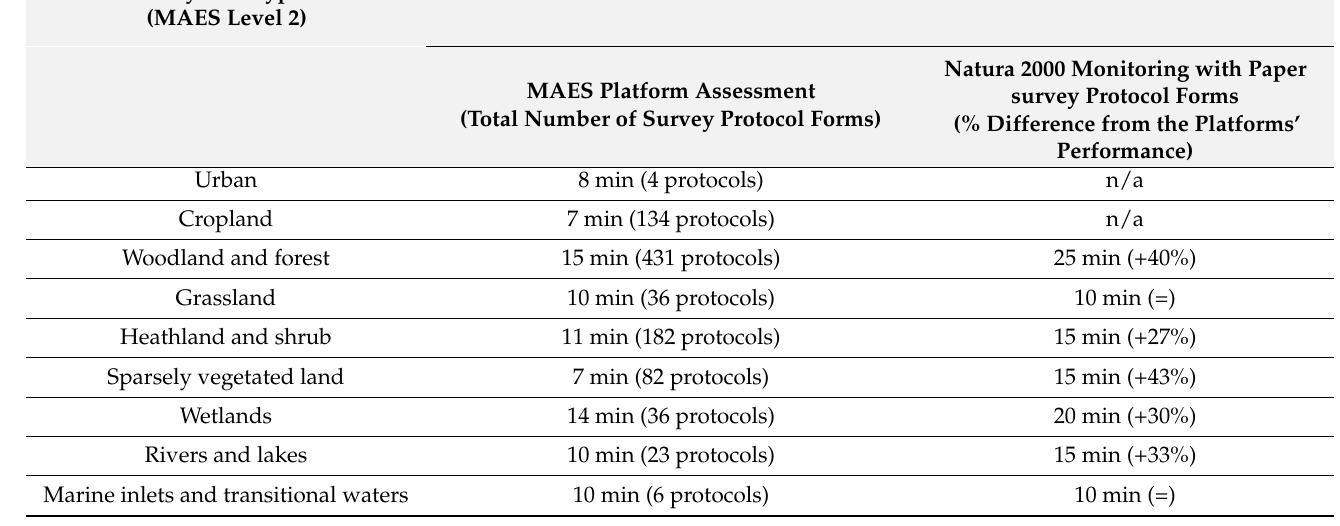
Table 3. Time spent to complete a full assessment at each ecosystem type (plot) using the MAES_GR platform in comparison with the relevant action during the habitat monitoring project in Greece.